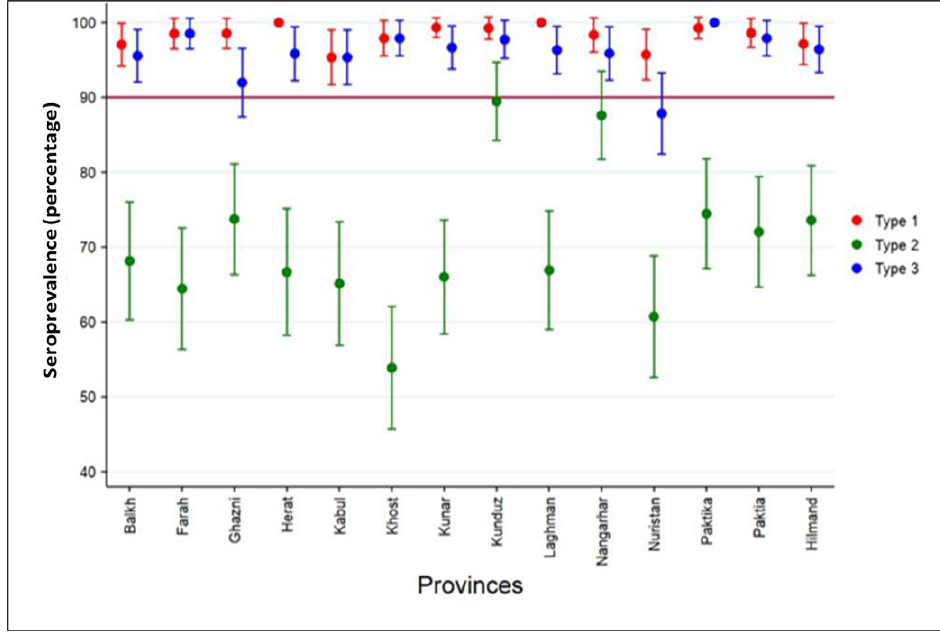
Figure 3. Seroprevalence by poliovirus serotype and province of residence, Afghanistan, 2017 .